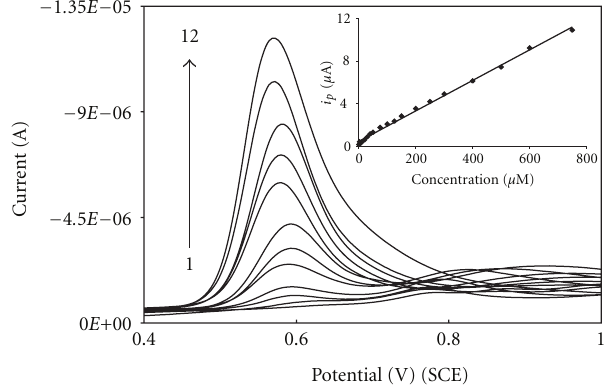
Figure 5: Di ff erential pulse voltammogram of MMF at di ff erent concentrations: (1) 0.5, (2) 2.5, (3) 10, (4) 25, (5) 50, (6) 100, (7) 150, (8) 300, (9) 400, (10) 500, (11) 600, and (12) 750 μ M. Insert: calibration plot for the determination of